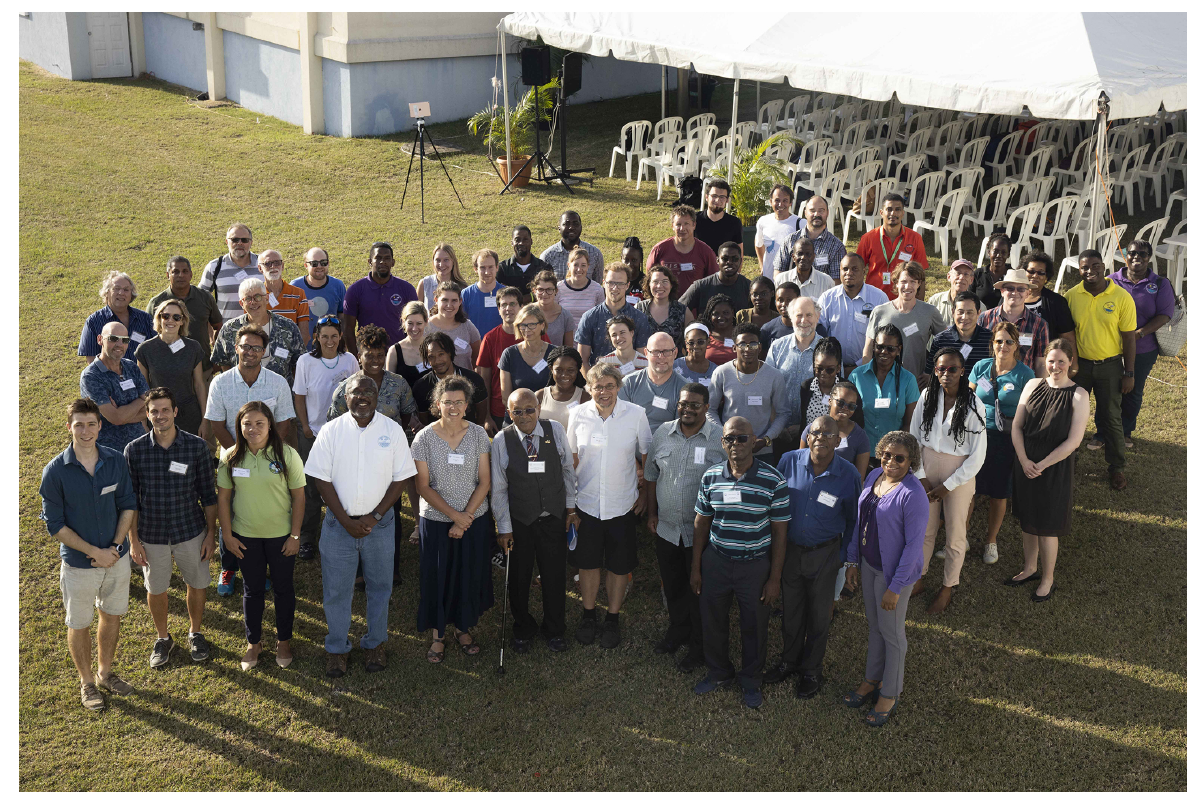
Figure 21. “From BOMEX to EUREC 4 A” symposium participants (photo by Frédéric Batier). Pat S. R. Callender (front, third from right) and Clyde Outram (front center, with cane) participated in BOMEX.